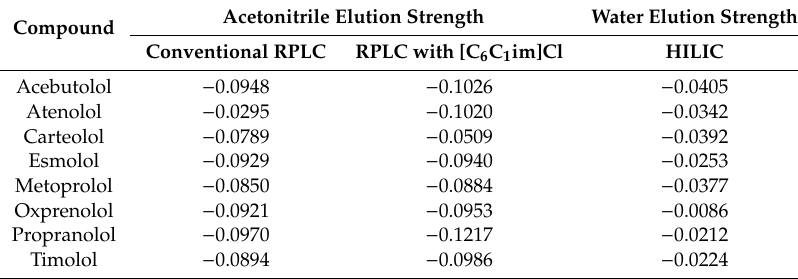
Table 1. Elution strength of the